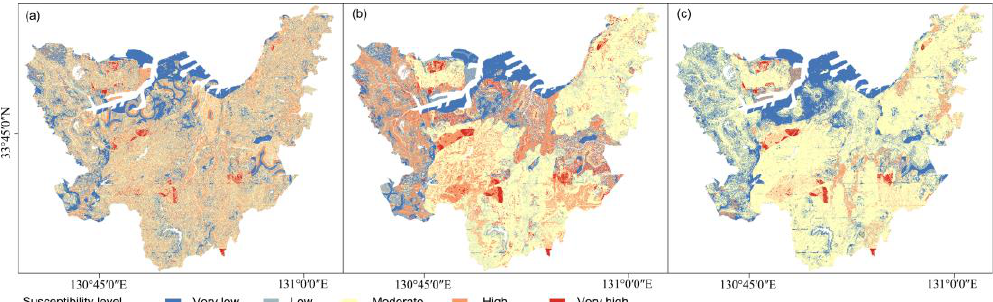
Figure 8. Landslide susceptibility mappings (LSMs) obtained using ( a ) random forest (RF) model; ( b ) deep belief network (DBN) model; and ( c ) support vector machine (SVM) model. Table 3. Area percentages of various susceptibility levels.